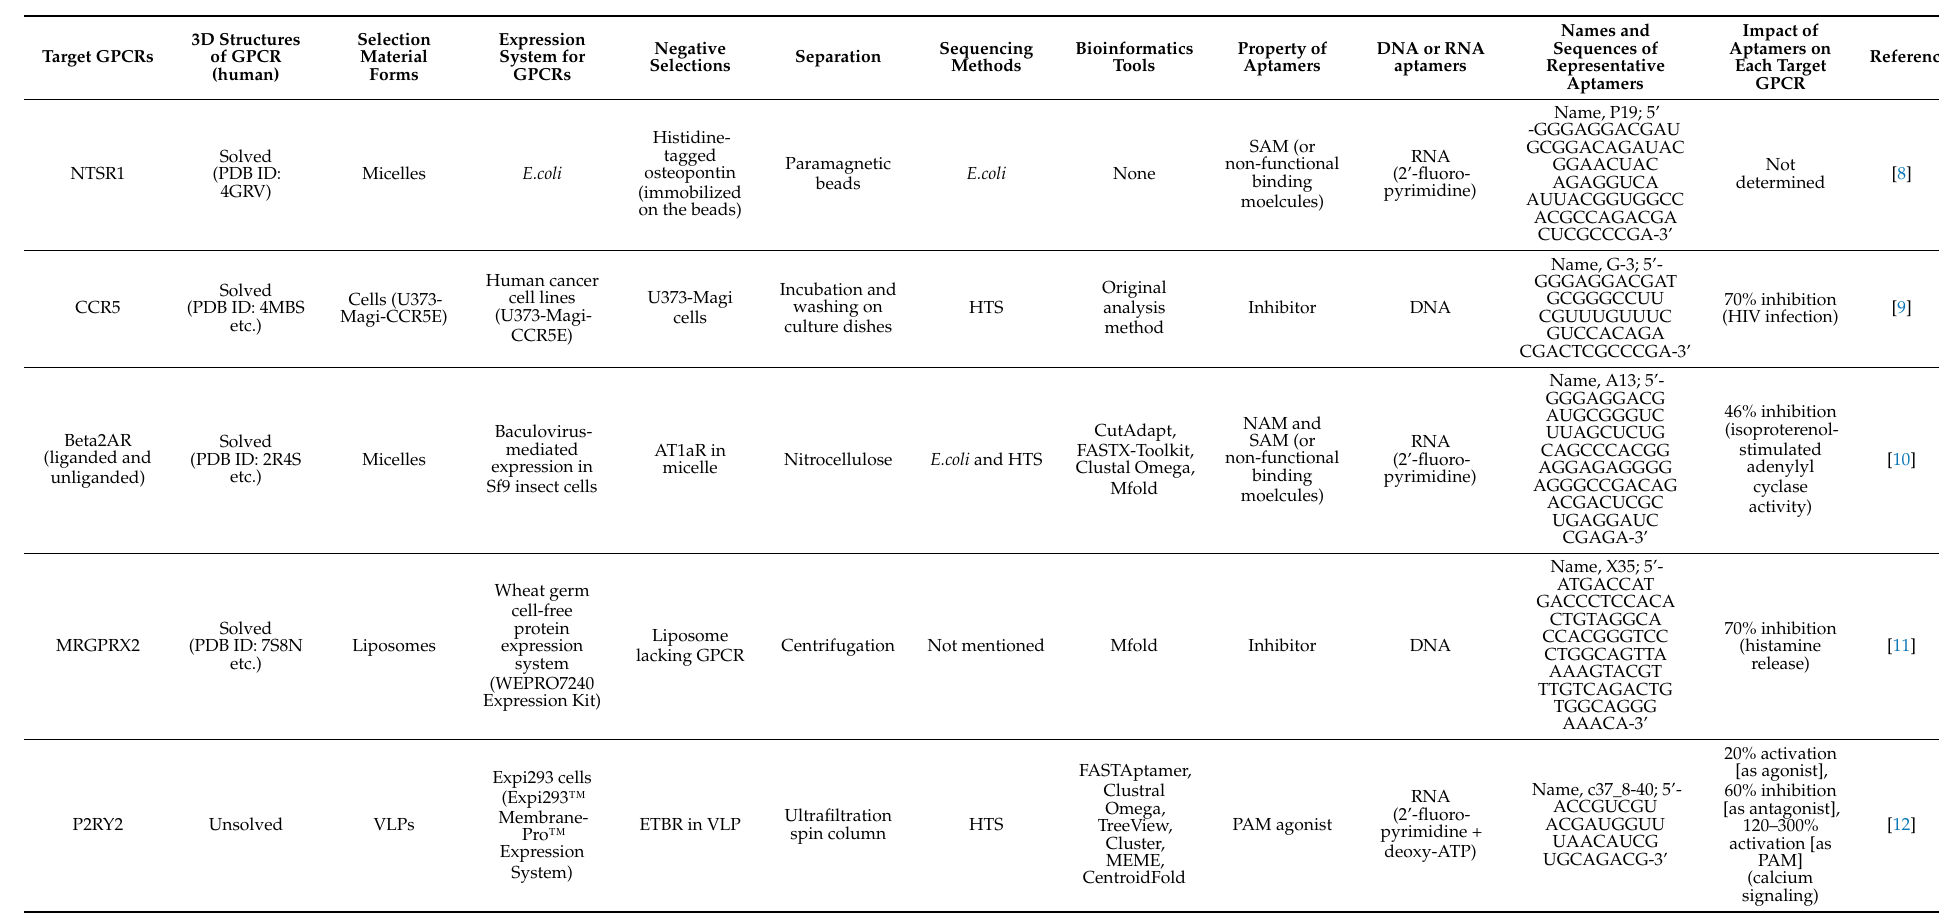
Table 1. Reports on aptamers targeting